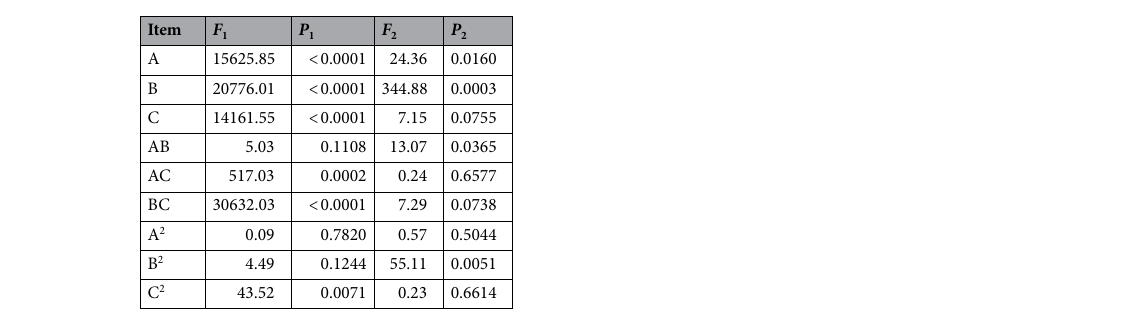
Table 5. Significance test of regression